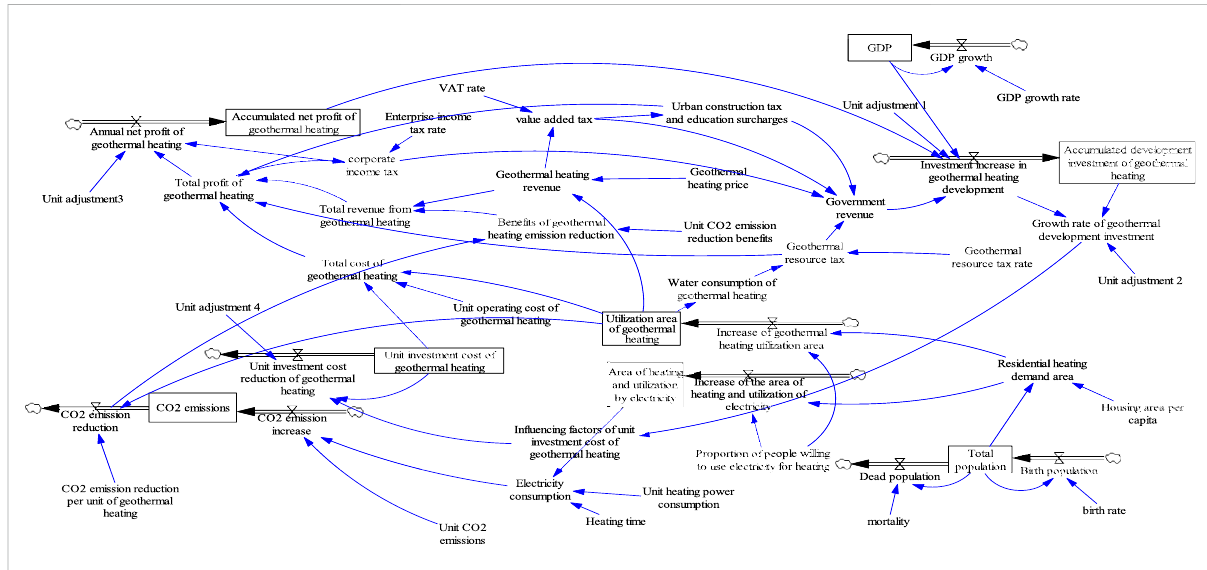
FIGURE 4 The dynamic fl ow diagram of the geothermal resource tax system in non-central heating areas.